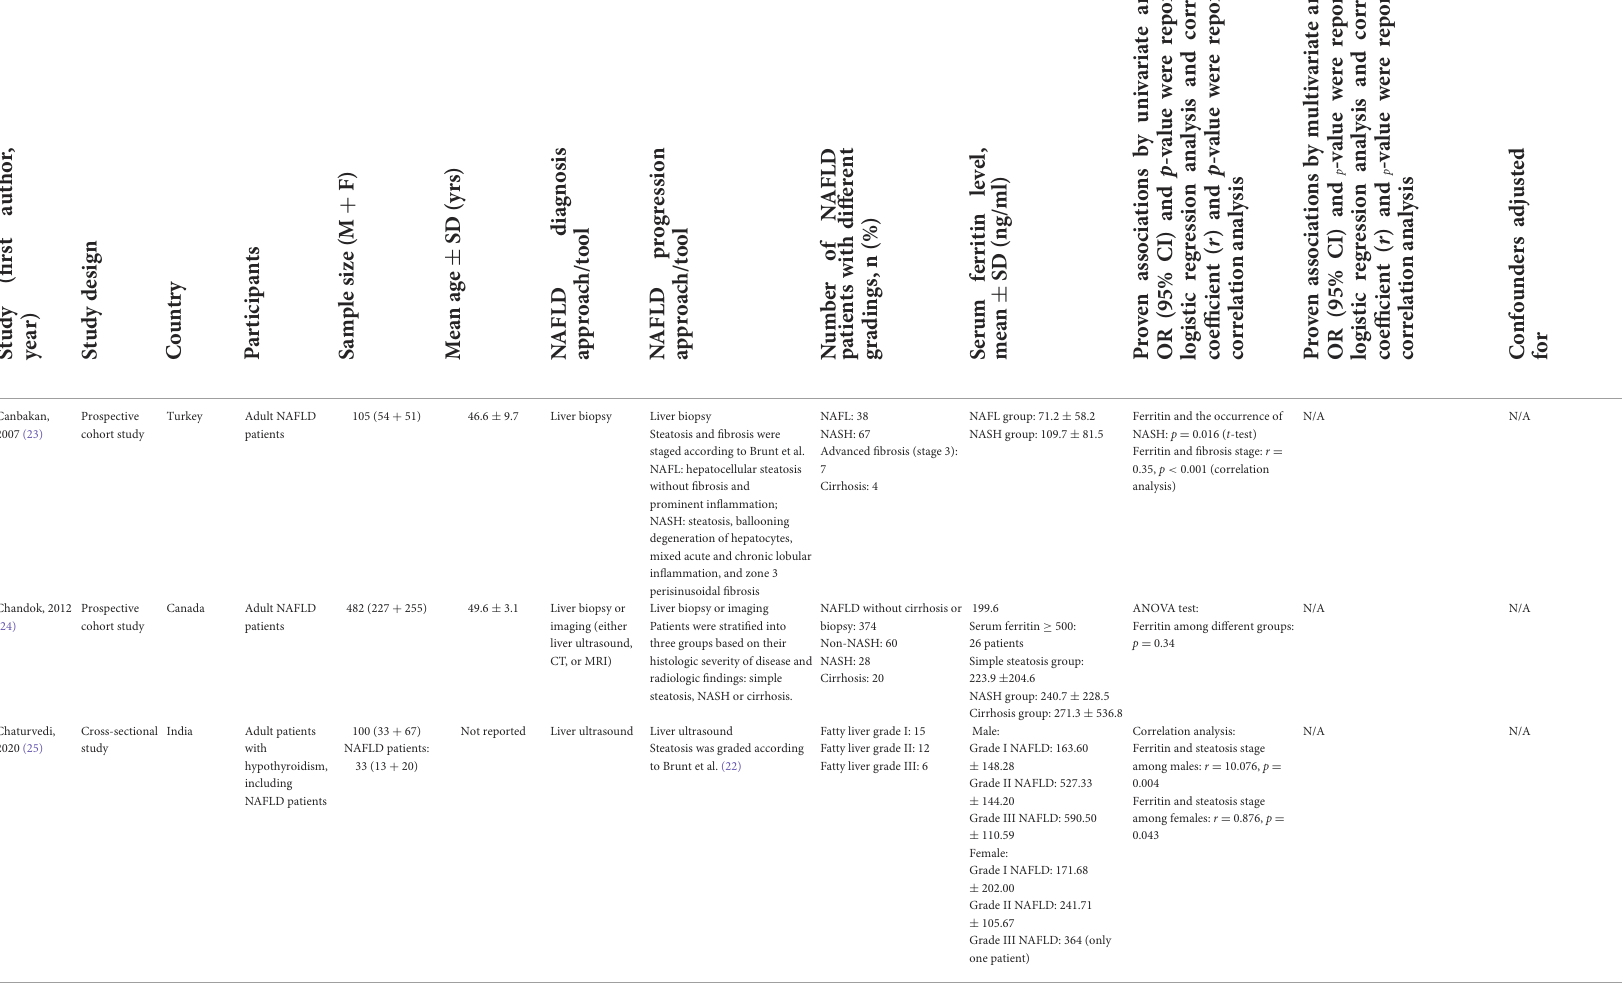
Correlationanalysis: Ferritinandsteatosisstage amongmales: r = 10.076, p = 0.004 Ferritinandsteatosisstage amongfemales: r = 0.876, p = 0.043